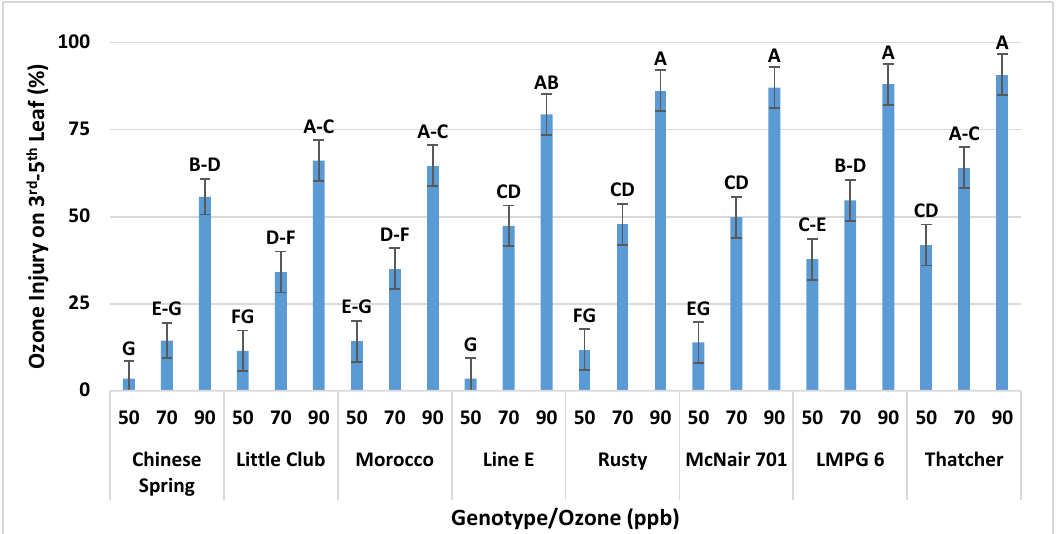
Figure 7. Average (±SE) O 3 injury (on the third – fifth leaf) of rust near-universal susceptible genotypes, Figure 7. Average ( ± SE) O 3 injury (on the third–fifth leaf) of rust near-universal susceptible genotypes, at three different O 3 levels, exposed for 14 days (12 h/day), at 25 °C and 50% RH, in OPECs. Injury at three di ff erent O 3 levels, exposed for 14 days (12 h / day), at 25 ◦ C and 50% RH, in OPECs. Injury was was visually estimated, under constant light conditions according to a 0 – 100% scale. Mean were visually estimated, under constant light conditions according to a 0–100% scale. Mean were statistically statistically separated using Tukey-Kramer adjustment for multiple comparisons. Means marked separated using Tukey-Kramer adjustment for multiple comparisons. Means marked with the same with the same letter are not significantly different at α = 0 .05. letter are not significantly di ff erent at α =